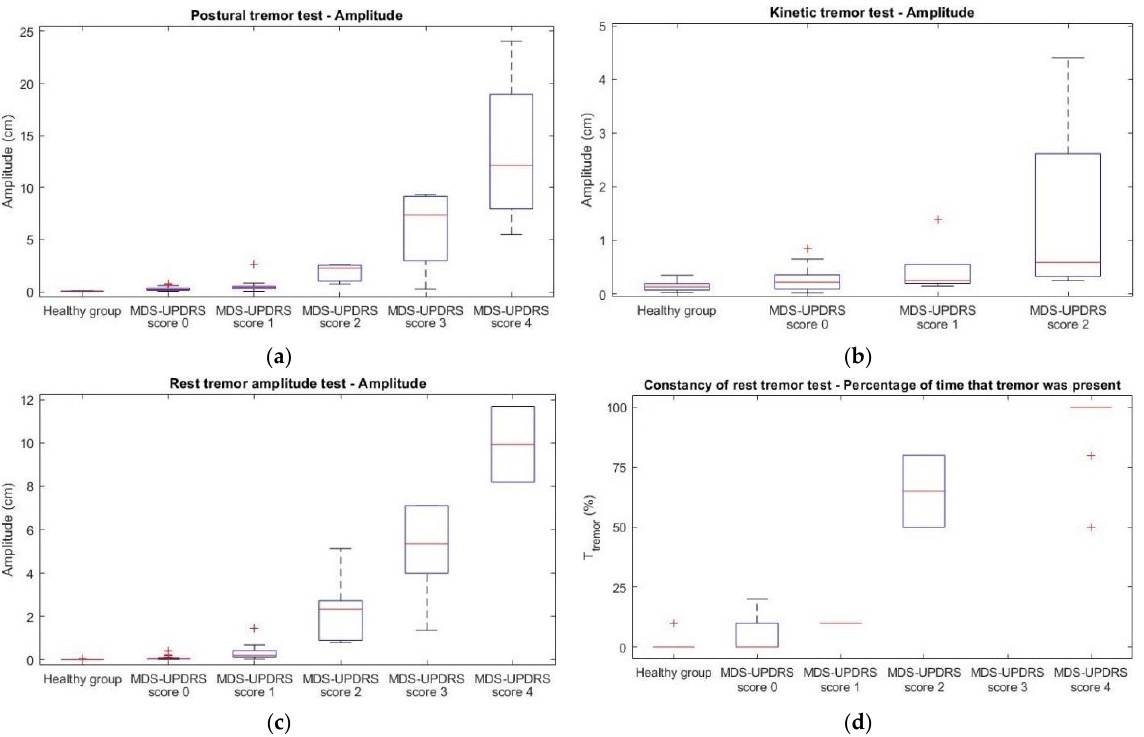
Figure 3. Boxplots of the total amplitude of the postural ( a ), kinetic ( b ), and rest tremor ( c ) tests, and of the T tremor of the constancy of rest tremor test ( d ) in the healthy group and the patient population (per MDS-UPDRS score).